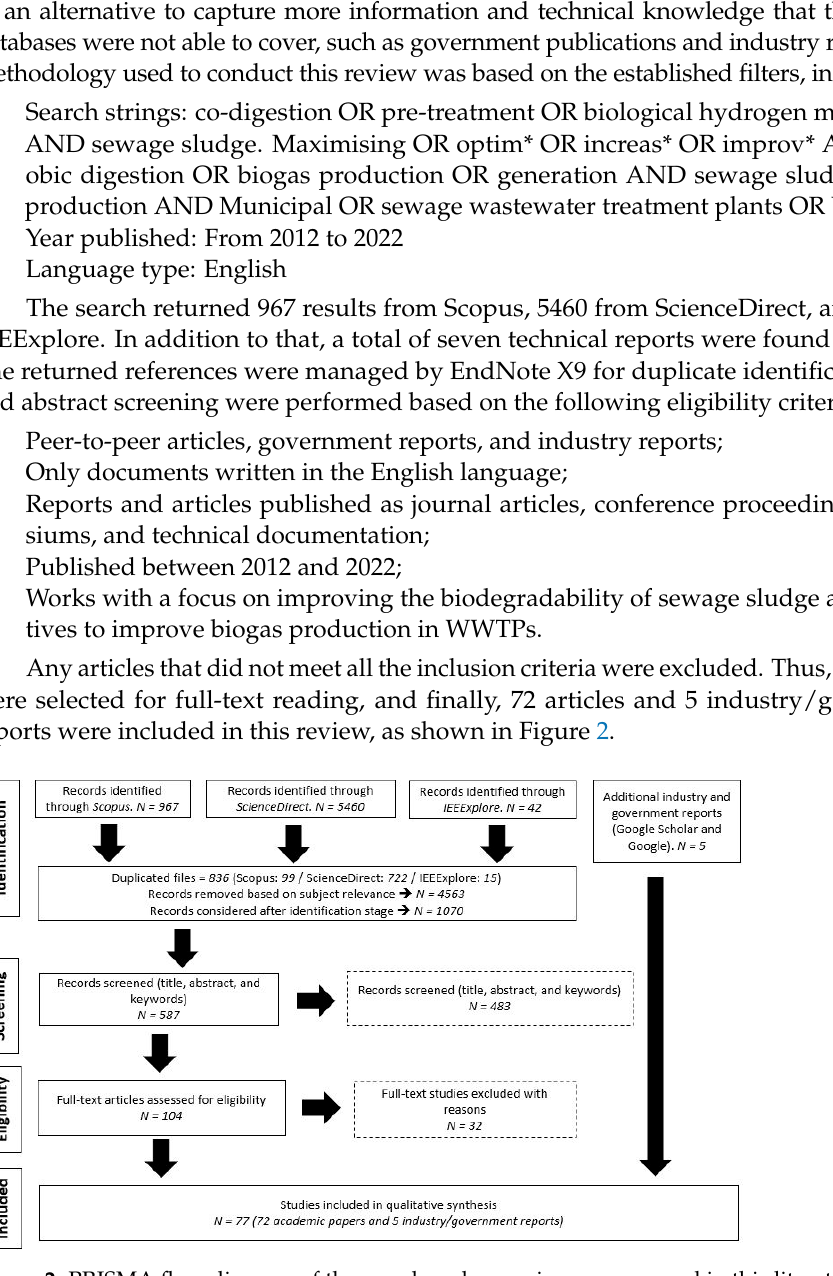
Figure 2. PRISMA flow diagram of the search and screening process used in this literature